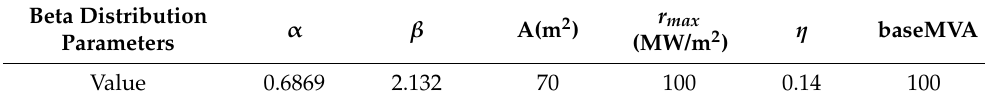
Table 2. Beta distribution parameters.